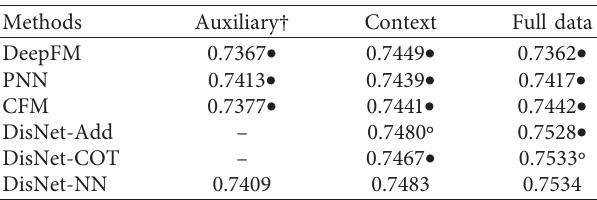
Table 4: Testing AUC comparison of context-aware models on the Taobao-Fresh